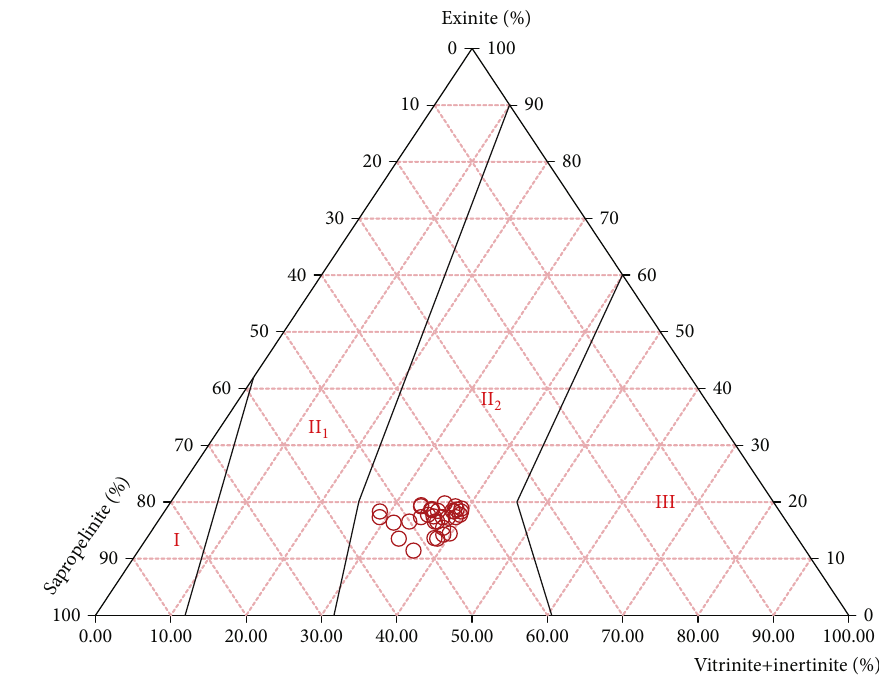
Figure 6: Ternary diagrams of organic maceral components in well DP1.